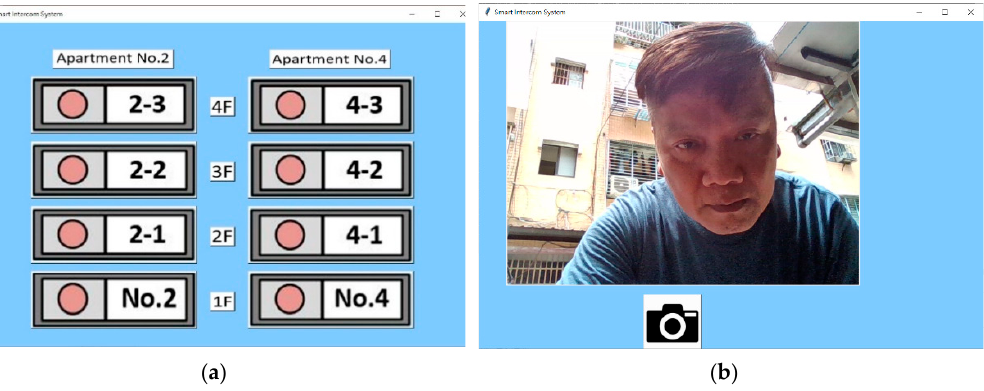
Figure 12. ( a ) The standby screen of the system. ( b ) The camera to take a